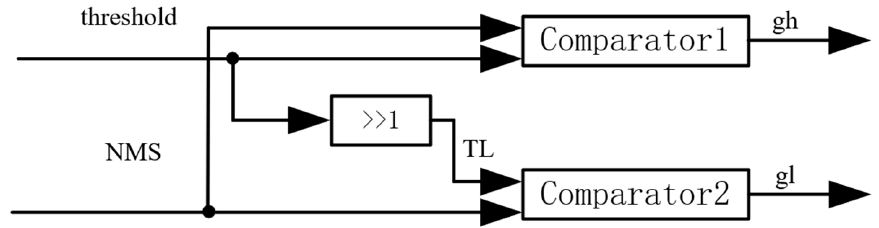
Figure 16. Architecture of Binarization.